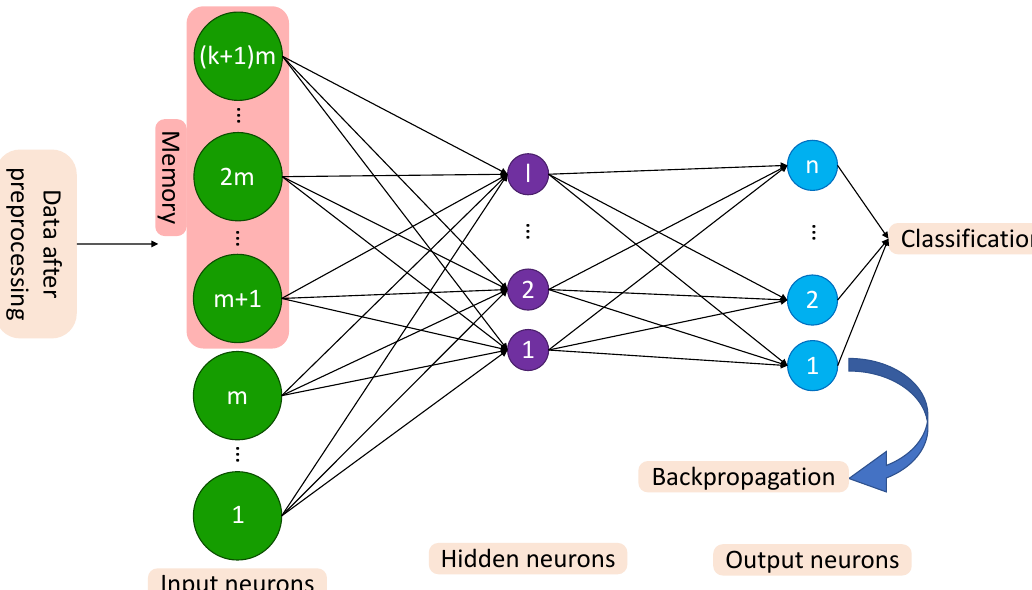
Figure 2. A MANN classifier based on k memory steps. The number of hidden neurons is set as (cid:112) ( l = k + 1 ) mn